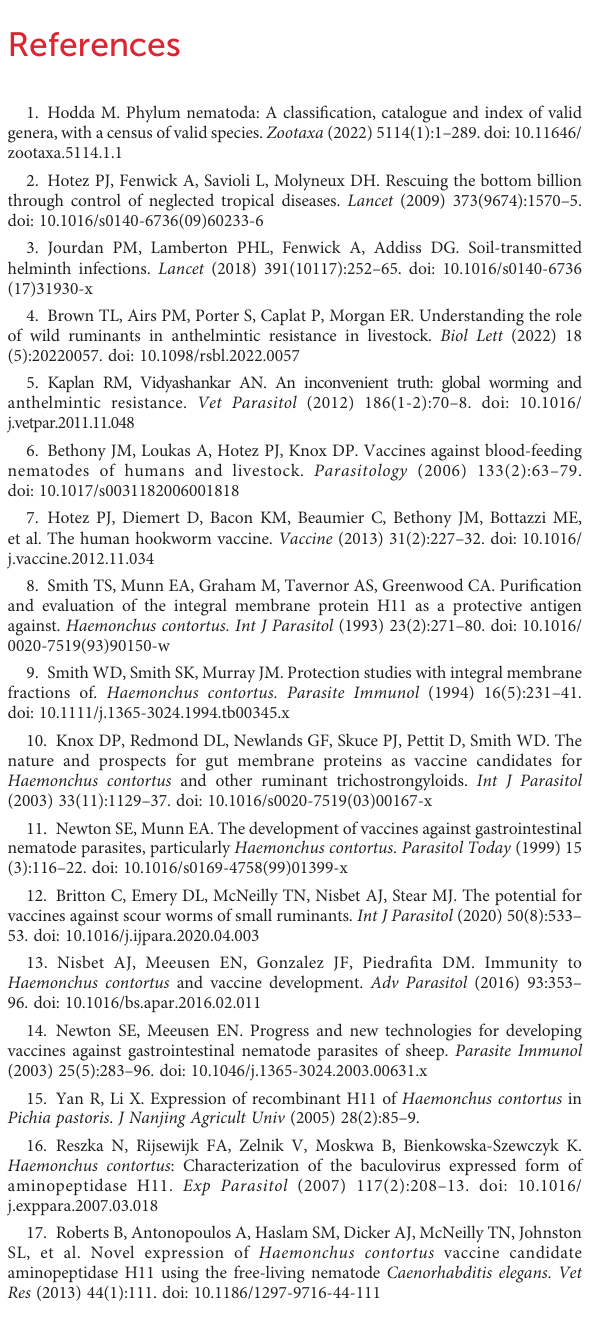
SUPPLEMENTARY TABLE 2 Results from domain enrichment analysis of N-glycoproteins of native H11 from Haemonchus contortus.